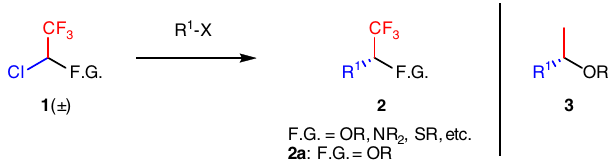
Fig. 1 Proposed pathway towards formation of α -CF 3 -substituted